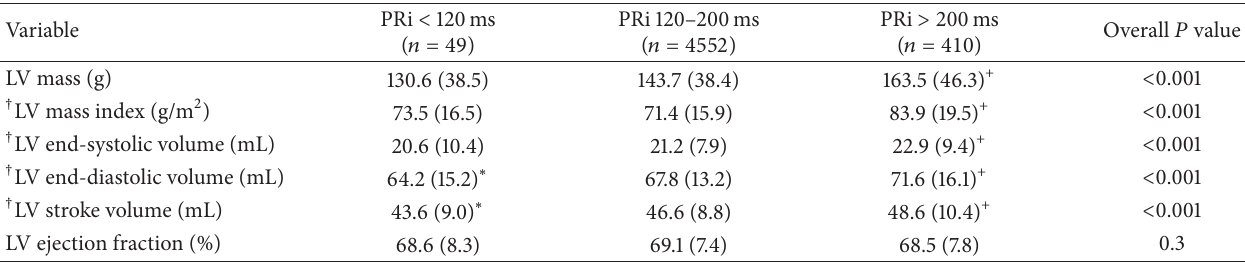
Table 3: Left ventricle (LV) ejection fraction and measures by PR interval (PRi).